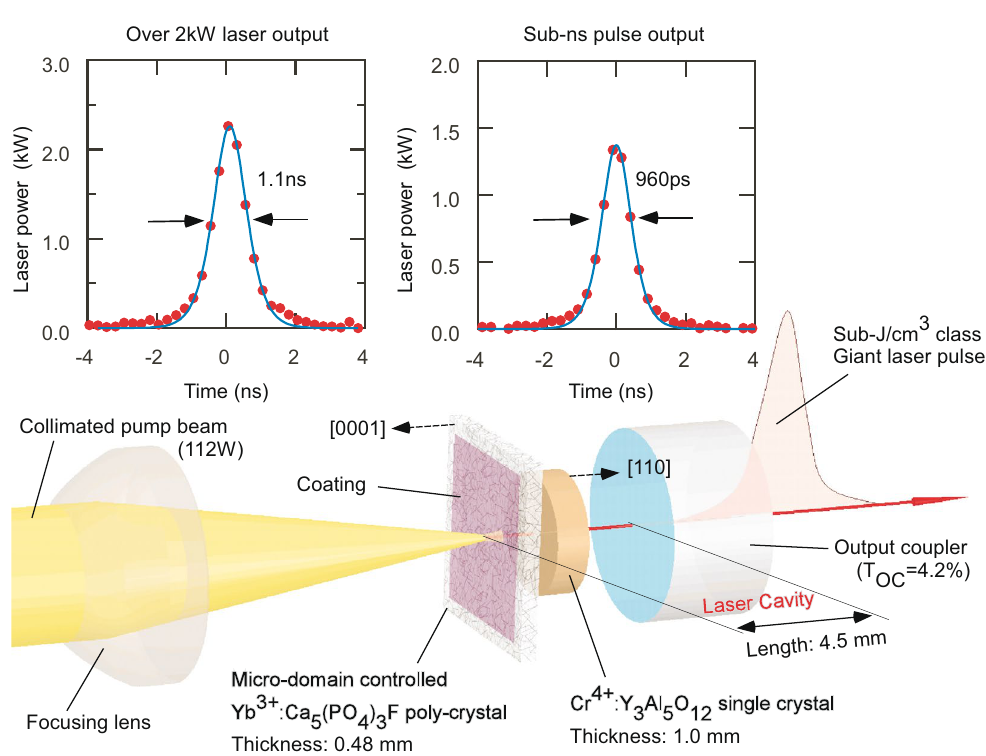
Figure 5. Experimental setup and generated giant pulses of the laser oscillation in Yb:FAP with quantum- controlled